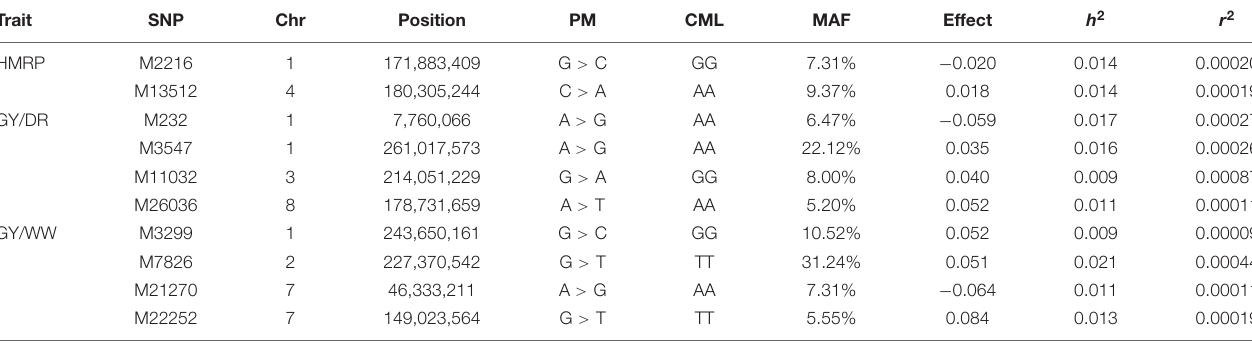
TABLE 5 | Significant SNPs for drought-tolerance index and grain yield in drought and well-watered conditions, with the SNP position (chromosome and position), polymorphism (PM) of the SNP (Reference > Alternative), genotype of CML376 (CML) for the given SNP, minor frequency allele, effect of allele substitution, heritability, and r 2 for the GWAS of BC1S1 generation.